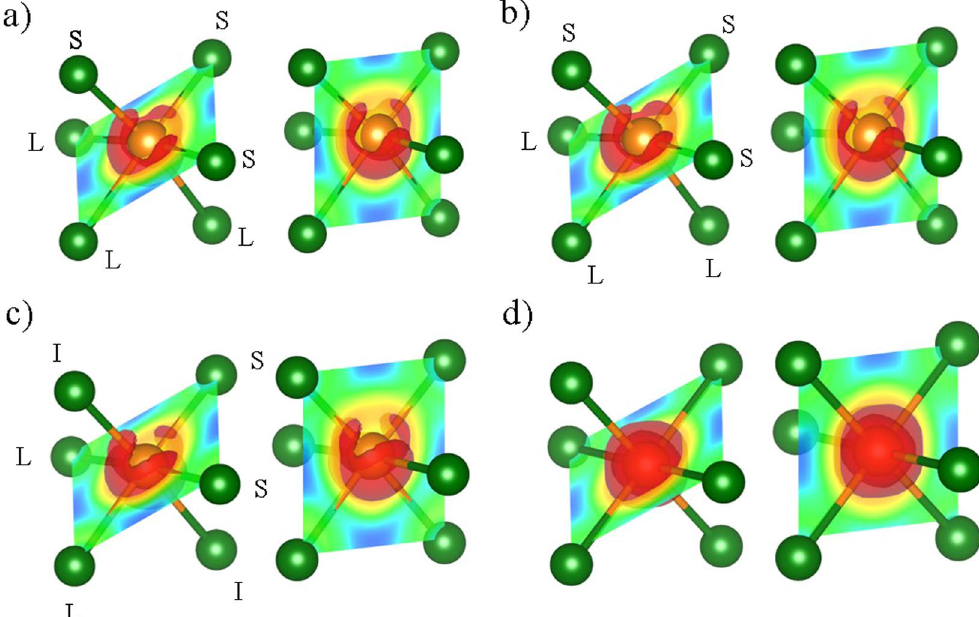
Figure 8. Electron localization functions of the different structures, as determined by the DFT calculations: ( a ) R3m, ( b ) P1, ( c ) Cm, and ( d ) Fm3m. Red isosurfaces correspond to ELF = 0.85. Left and right figures for each structure exhibit different 2D planes that contain bonds. In the 2D cross-section view, the regions of high ELF and low ELF are represented with red color and blue color,